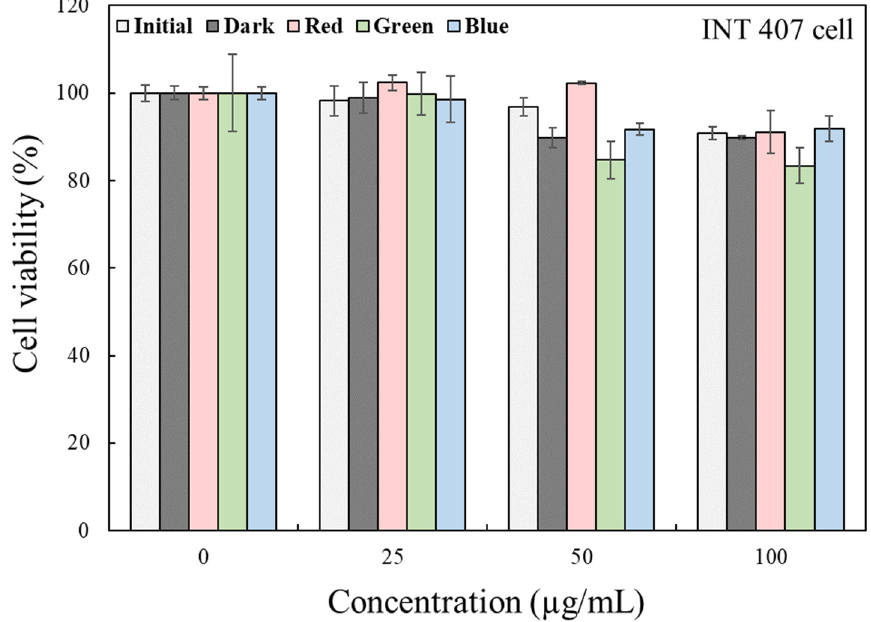
Figure 6. Effects of 3 LED-irradiated kimchi broths on viability of the INT 407 cell. The LED- irradiated kimchi broths were extracted and evaluated for cell viability. Cells were treated with LED-irradiated kimchi extracts (0–100 µg/mL). After 24 h of incubation, viable cells were analyzed using MTT assay.